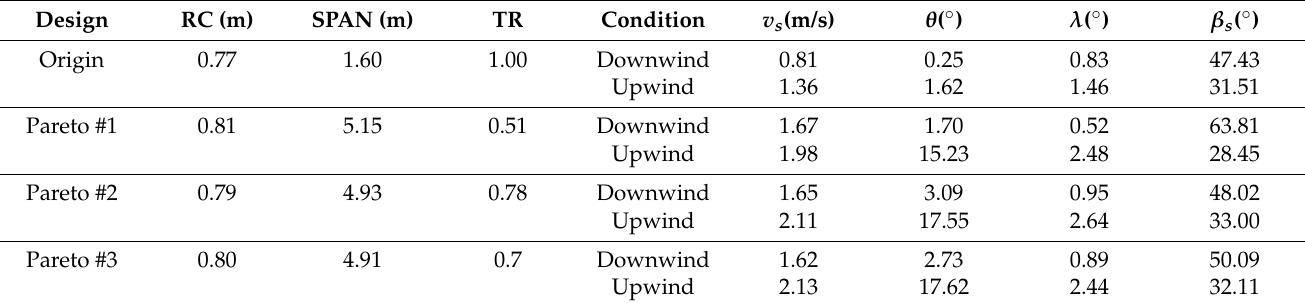
Figure 15. The influence of each of the two design variables on the optimisation objectives . Figure 15. The in fl uence of each of the two design variables on the optimisation objectives. Table 3. Optimisation